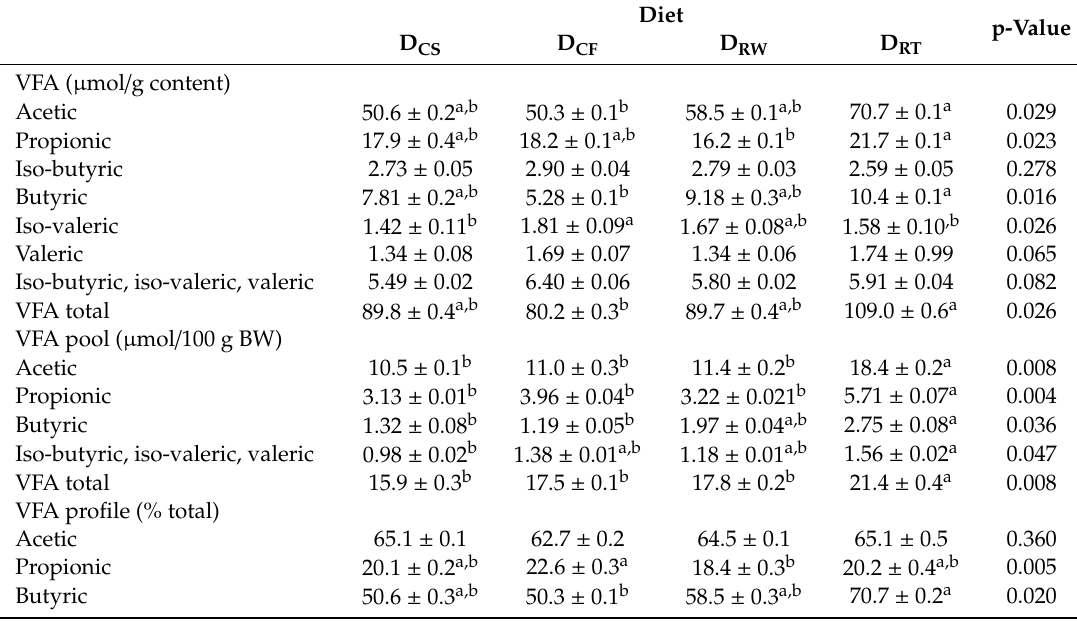
Diet: D CS —control standard diet, D CF —control high-fat diet, D RW —diet enriched with freeze-dried raw cocoa beans extract, D RT —diet enriched with freeze-dried roasted cocoa beans extract. SEM: standard error of the